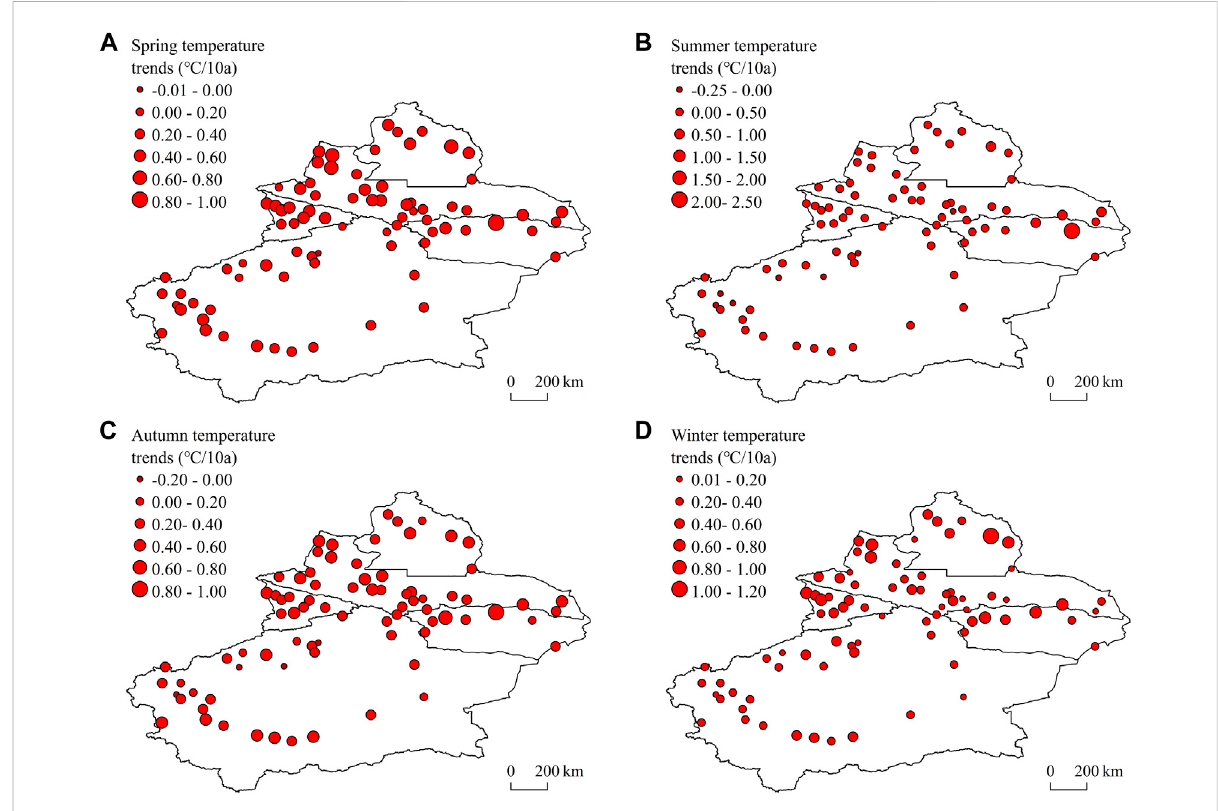
FIGURE 4 Variation trends in temperature during different seasons (A – D) in XJ and its